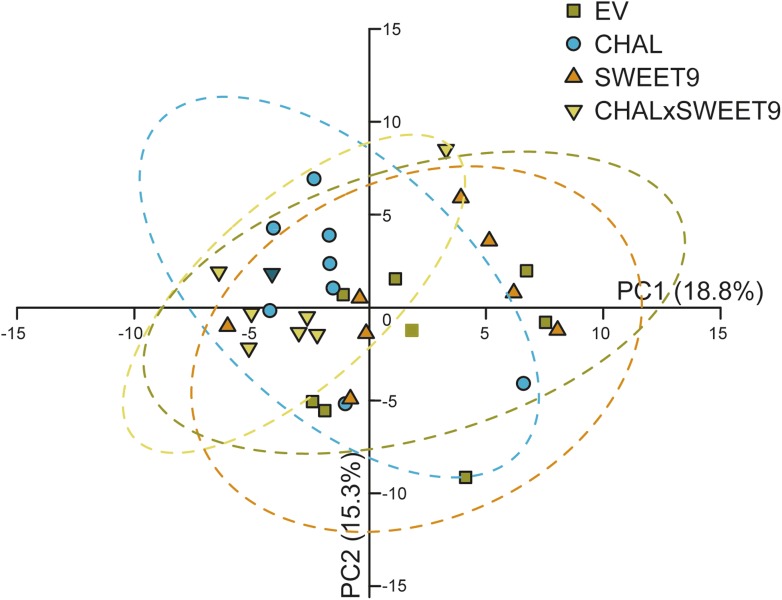
Principal components analysis (PCA) of leaf volatiles.Leaf volatiles were collected overnight from un-attacked leaves from seven individual plants per genotype. 94 volatiles were detected and analyzed by PCA, and principal components (PCs) 1 and 2 of the transgenic lines were plotted against each other (dashed circles represent 95% confidence intervals).